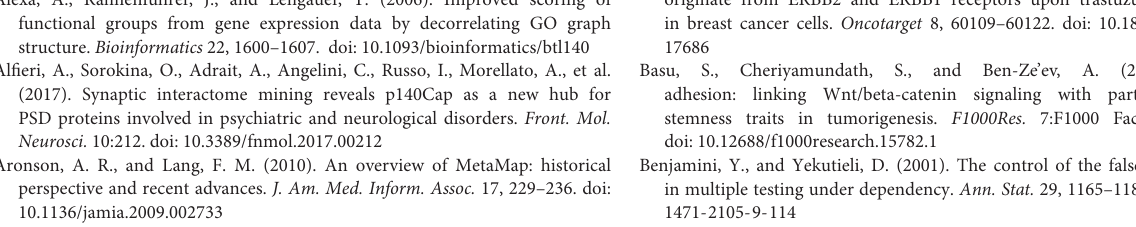
TABLE S3 | Community structure for cancer and synaptic p140Cap interactomes. Columns B and C contain the lists of genes and their IDs, columns D-I, R, and S